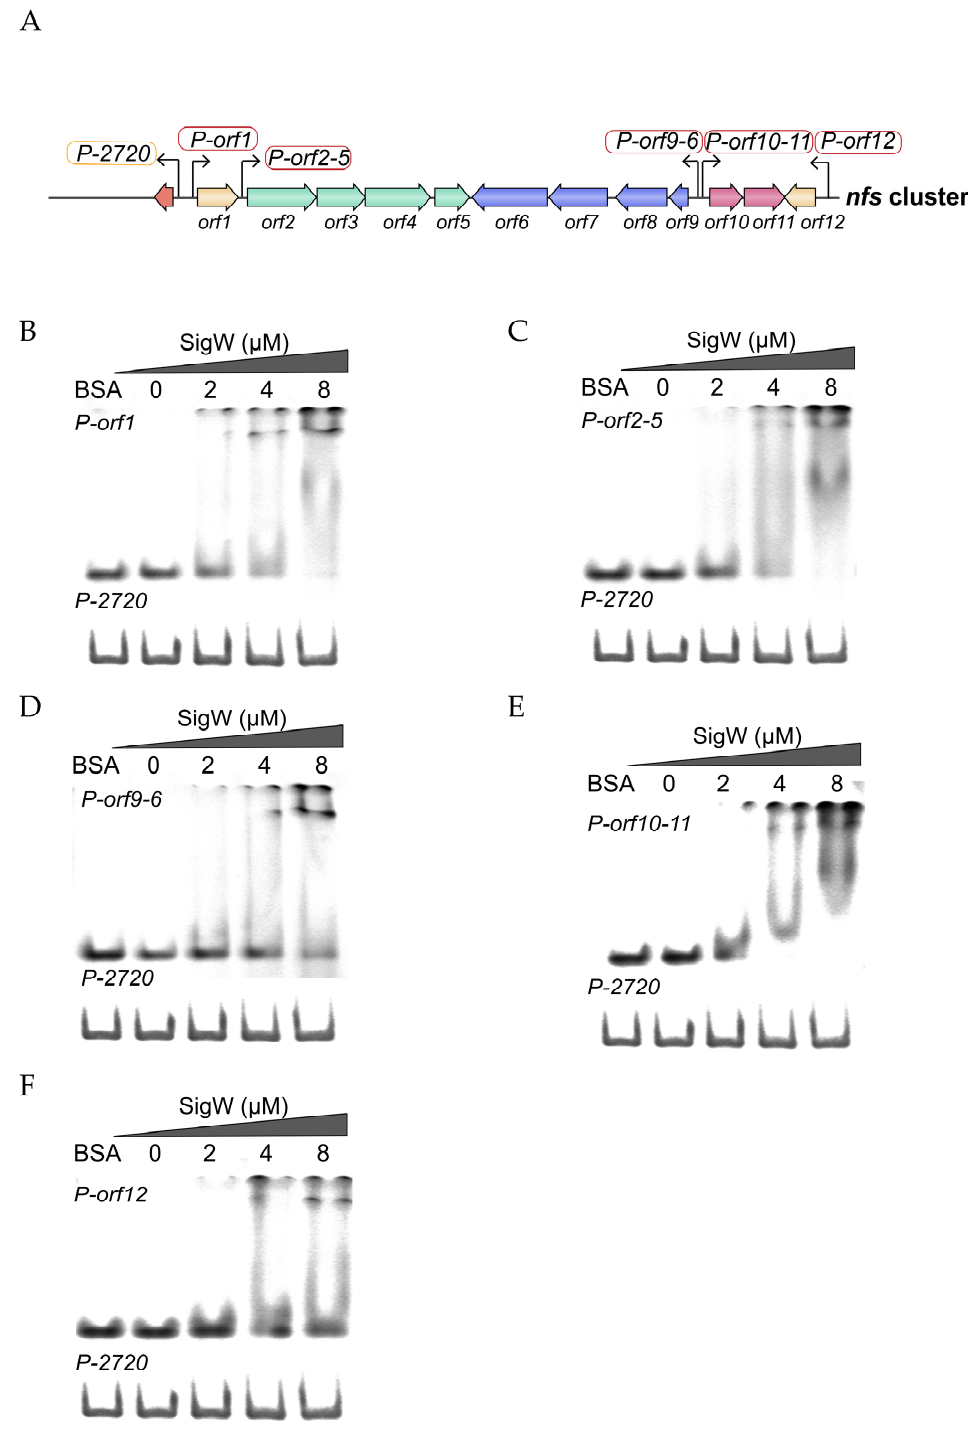
Figure 5. SigW binds directly to promoters on the nfs cluster for regulatory action. Localization map of promoters on the nfs cluster ( A ). The electrophoretic mobility shift assay shows that SigW binds to the promoter region of the wild-type ( B ) orf1 , ( C ) orf2 – 5 , ( D ) orf9 – 6 , ( E ) orf10 – 11 , and ( F ) orf12, respectively. Each reaction mixture contained 0.3 µ M PCR products of the wild-type orf1 –217 to –1, orf2 –191 to –1, orf9 –225 to –1, orf10 –237 to –1, orf12 –246 to –1, and PD2720 –210 to –1. The protein concentrations are indicated above the lane. BSA and P-2720 were used as negative controls. Data are representative of three independent